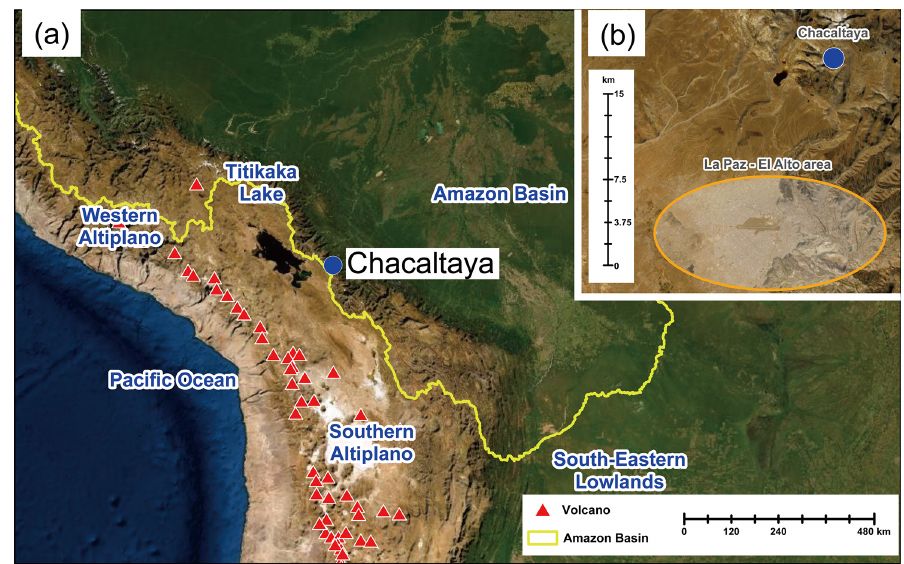
Figure 1. (a) True-color satellite image showing the location of CHC (blue circle) and its surrounding area. The yellow line presents the boundary of the Amazon basin. Red triangles denote the volcanoes in this area. (b) A zoomed-in true-color satellite image showing the distance between CHC and the La Paz–El Alto metropolitan area (orange circle). Image sources: Esri, DigitalGlobe, GeoEye, i-cubed, USDA FSA, USGS, AEX, Getmapping, Aerogrid, IGN, IGP, swisstopo, and the GIS User